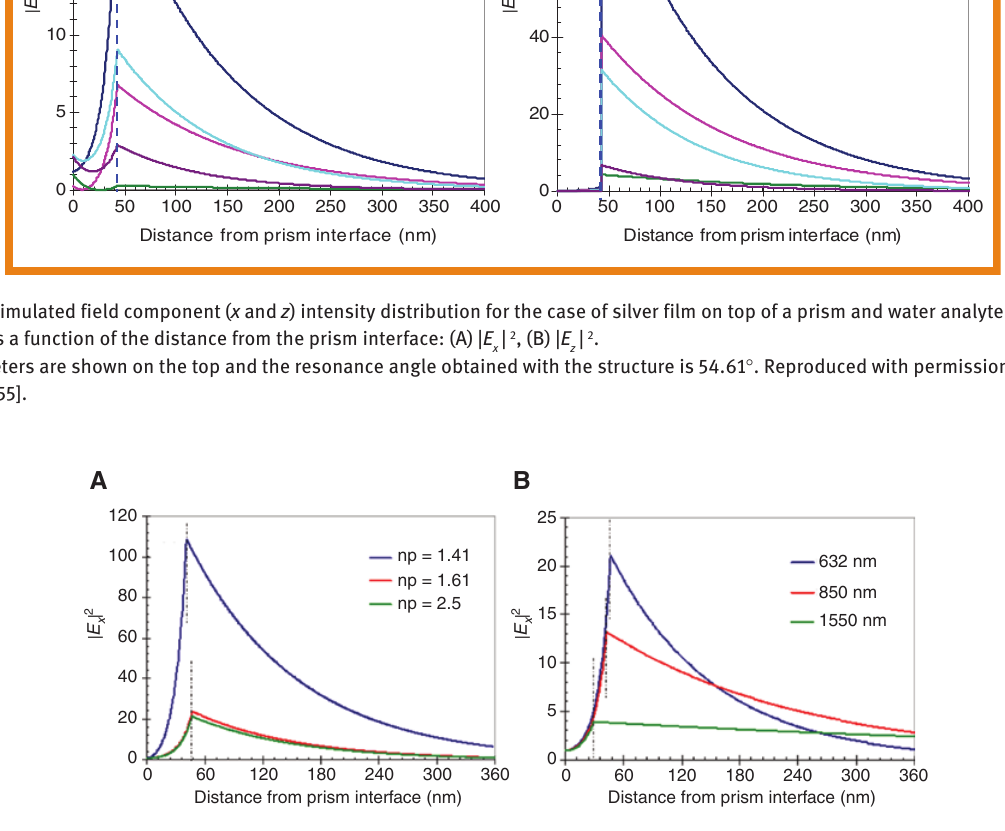
Figure 5: Simulated x -component of the electric field distribution for silver film on prism configuration with water as analyte, n (A) At different prism refractive indices with metal layer thicknesses d that were chosen to obtain resonance for each prism, refractive m indices are 41.5, 47.5, and 47 nm for 1.41, 1.61, and 2.5 prism refractive indices, respectively. (B) For different wavelengths at the resonance with the same metal thicknesses d for obtaining resonance in each wavelength, refractive indices are 47, 43.25, and 29.75 nm for 632, 850, m = 1.732. Reproduced with permission from Reference and 1550 nm, respectively, and fixed prism index n p